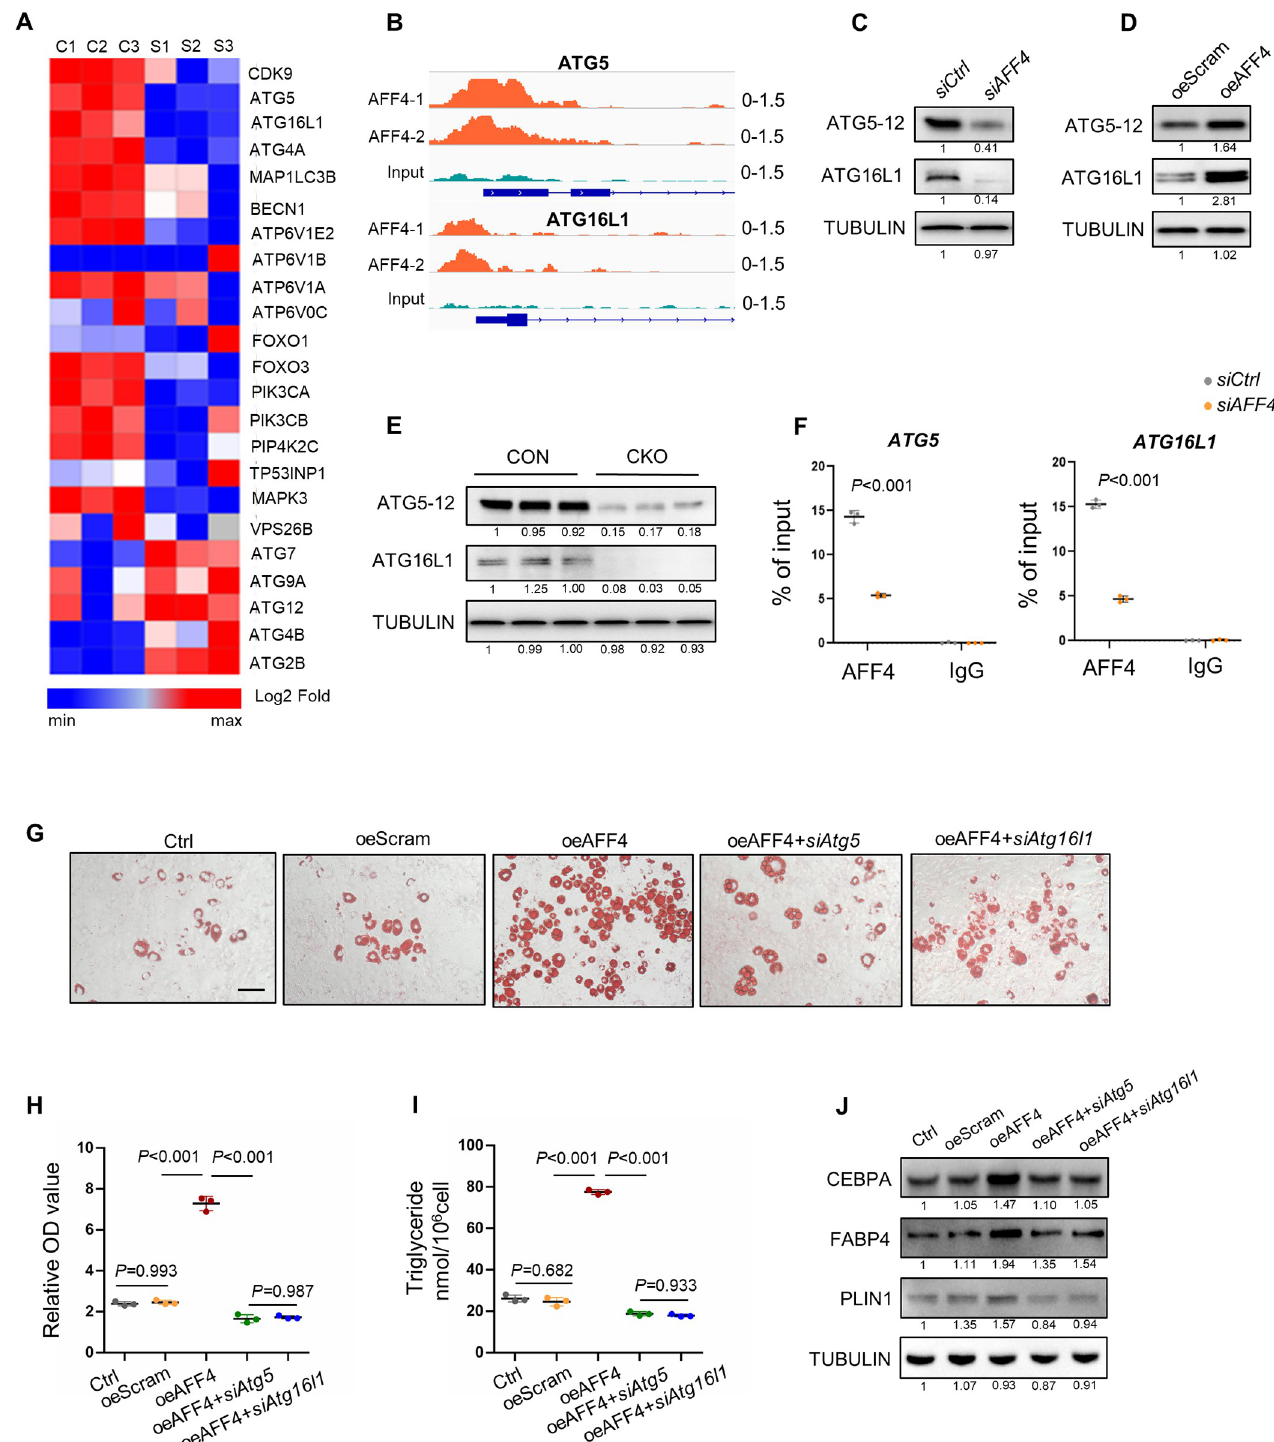
Fig 5. AFF4 regulates autophagy by targeting ATG5 and ATG16L1. (A) Heatmap of autophagy related genes in siCtrl and siAFF4 hMSCs. (B) ChIP-Seq analysis of AFF4 association on the promotor of ATG5 and ATG16L1 . (C-E) Western blot analysis of ATG5-12 and ATG16L1 expression in AFF4 depleted hMSCs (C), AFF4 overexpressing 3T3-L1 cells (D) and preadipocytes from CON and CKO mice (E). (F) ChIP-qPCR showed AFF4 binds to the promoter region of ATG5 and ATG16L1 . n = 3. (G-J) Silencing of Atg5 or Atg16l1 corrected enhanced adipogenesis of AFF4-overexpressing 3T3-L1 cells. (G) Representative images of oil red o staining. Scale bar, 25 μ m. (H) Quantitative analysis of oil red o staining. n = 3. (I) Triglyceride quantification. n = 3. (J)